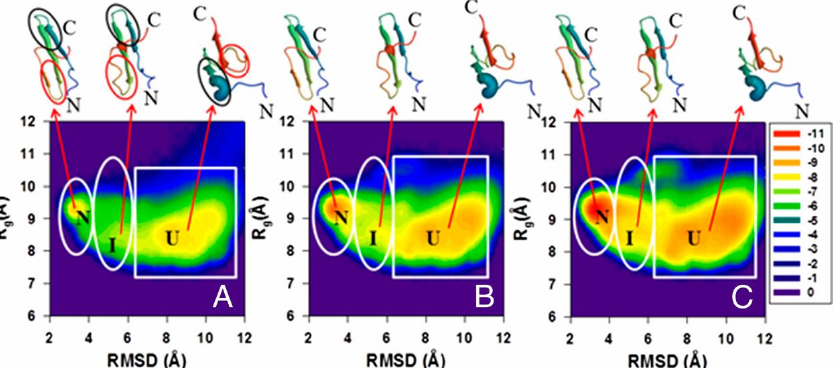
Figure 2. Variation of the distribution of conformational states in terms of FELs (in kcal/mol) along the C α -RMSD and R g order parameters for the wild-type FBP28 WW domain. The data have been collected from different sections of all 512 trajectory sets for the molecule (shown in ( A – C ), respectively). The FEL corresponding to the initial parts of the trajectories (with the average fraction of the native structures up to 20% of the maximum fraction) is shown in ( A ); the FEL from the middle parts of the trajectories (the fraction of the native structures between 20% and 50% of the maximum fraction) is shown in ( B ); and the FEL from the final parts of the trajectories (the fraction of the native structures exceeds 50% of the maximum fraction) is shown in ( C ), respectively. The letters “U”, “I” and “N” correspond to unfolded, intermediate and native states, respectively. The representative structures of unfolded, intermediate and native states are plotted on top of each state. Hairpin 1 and hairpin 2 are circled by black and red lines, correspondingly, in ( A ). Reproduced from R. Zhou et al.